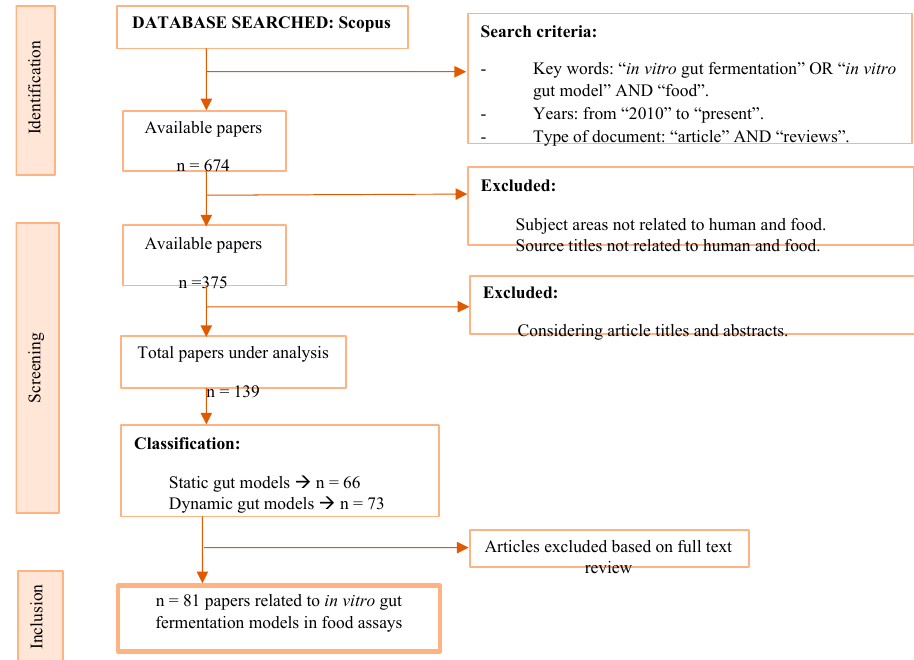
Figure 1. Flow diagram of data selection and identification process.